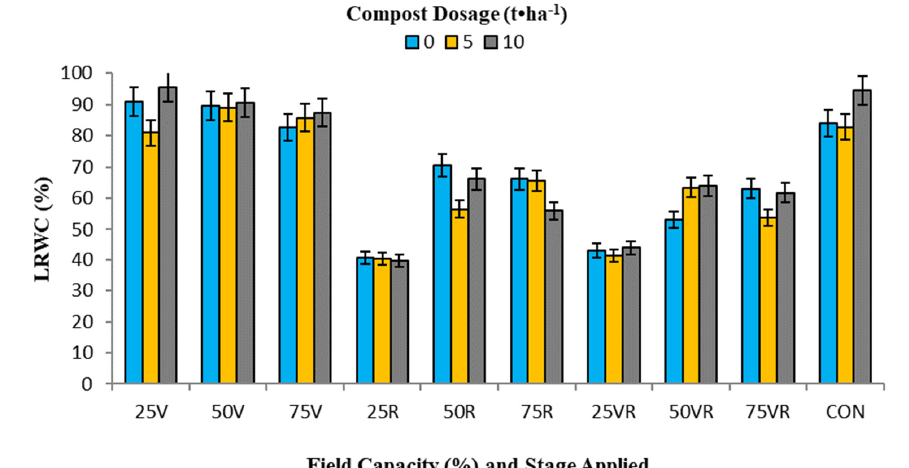
Figure 2. Effect of interaction of water regime, treatment stage and compost dosage on leaf relative water content (LRWC) at 8